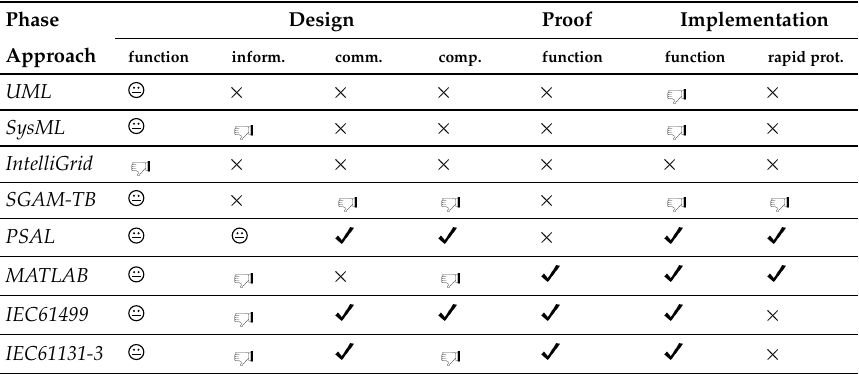
Table 2. Comparison of approaches and